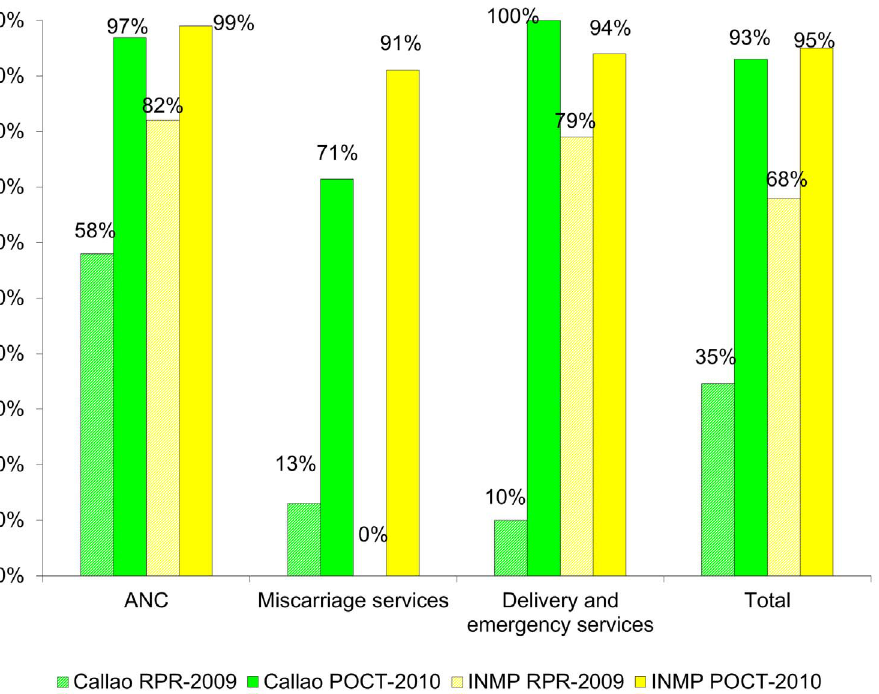
Figure 3. Comparative screening coverage: Ventanilla-Callao and INMP 2009 by RPR and 2010 by syphilis POCT. Syphilis screening coverage improved at the peripheral network of health centers in Ventanilla from 35% to 93% and at the INMP from 68% to 95% from 2009 to 2010.